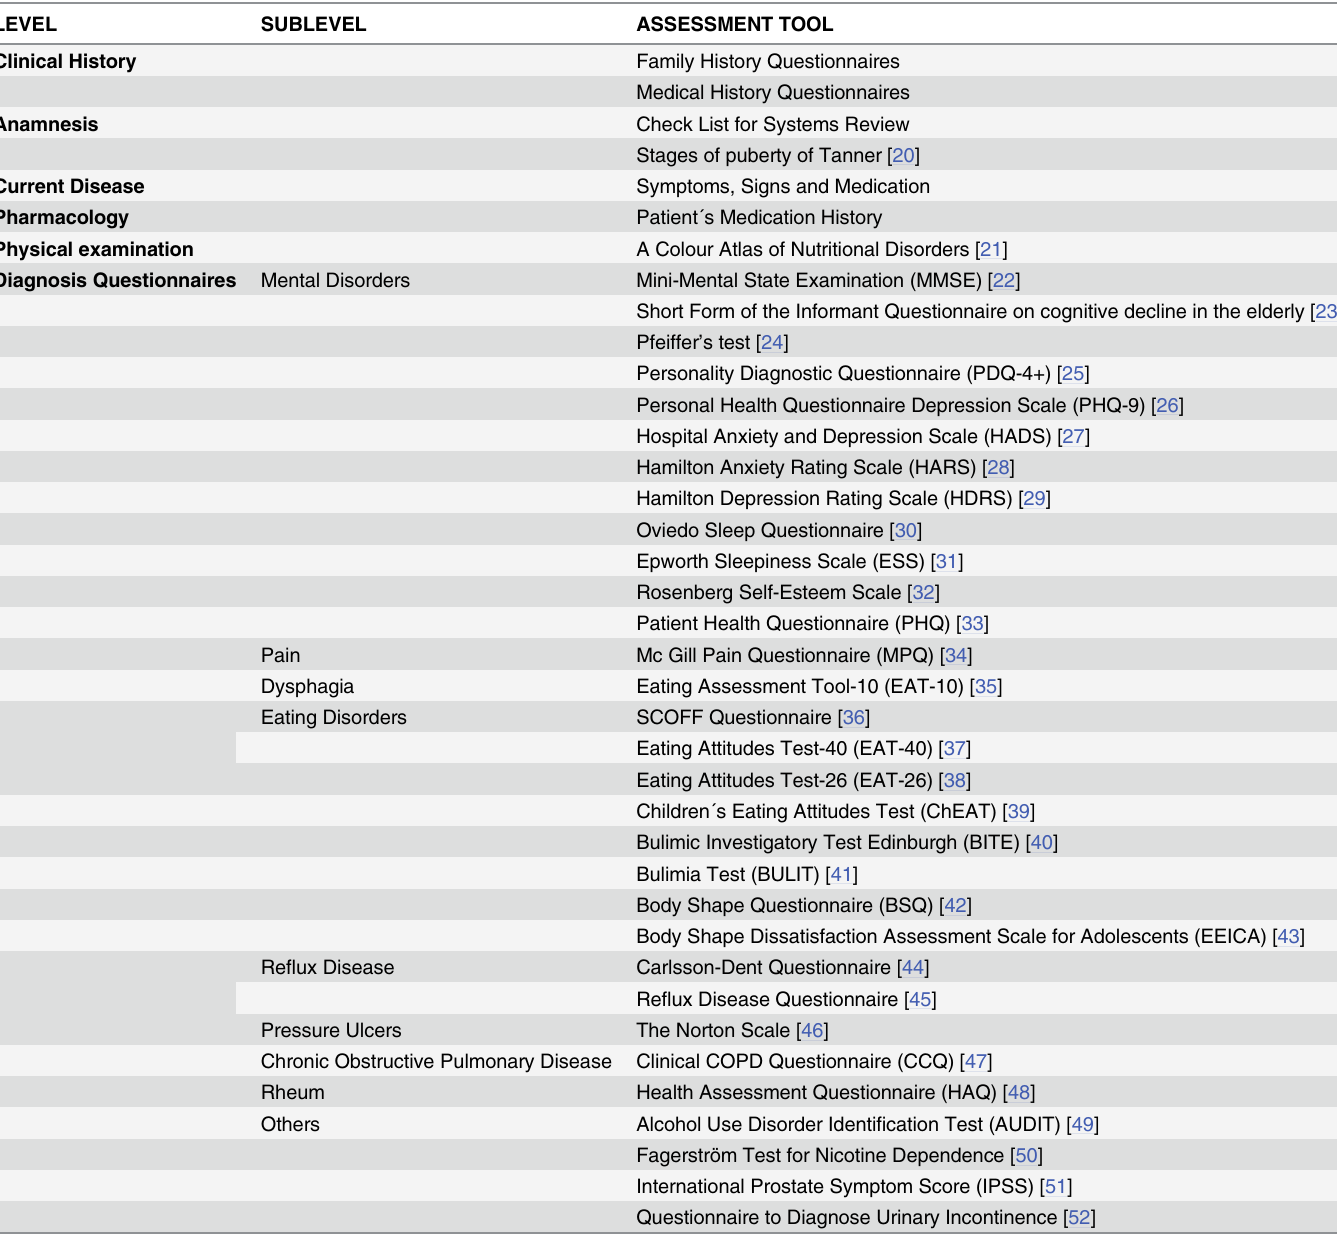
Table 1. Assessment tools of the module of Medical